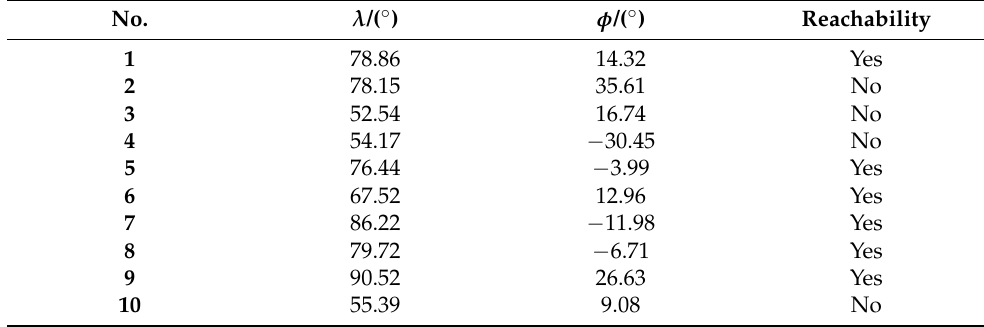
Table 3. Reachability tests for the random points.